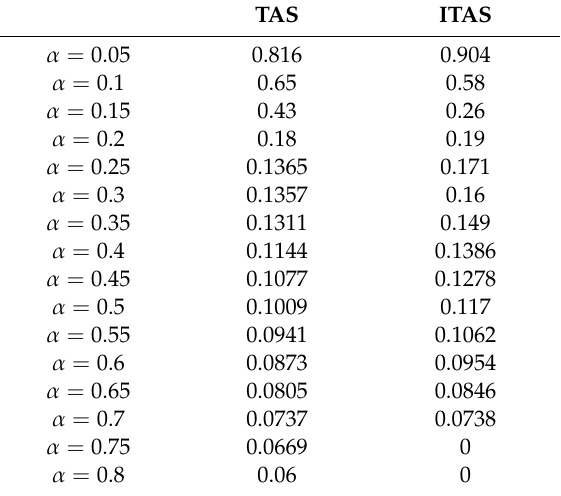
Table 5. Data statistics under di ff erent attack strategies δ =